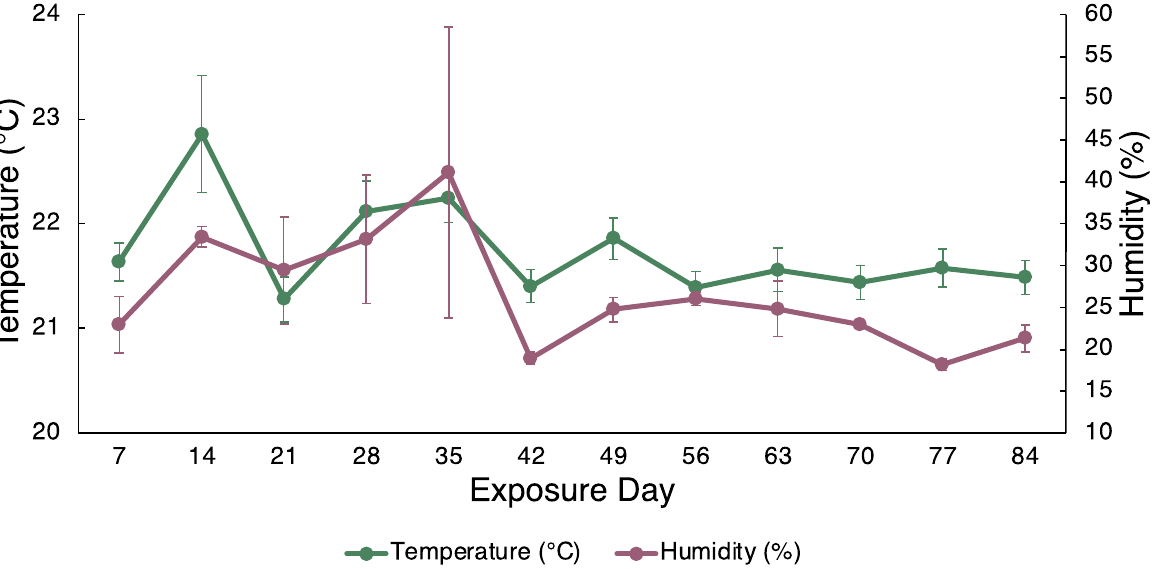
Figure 7. The average laboratory temperature (in °C) and humidity (in %) on each exposure day throughout the three-month study.